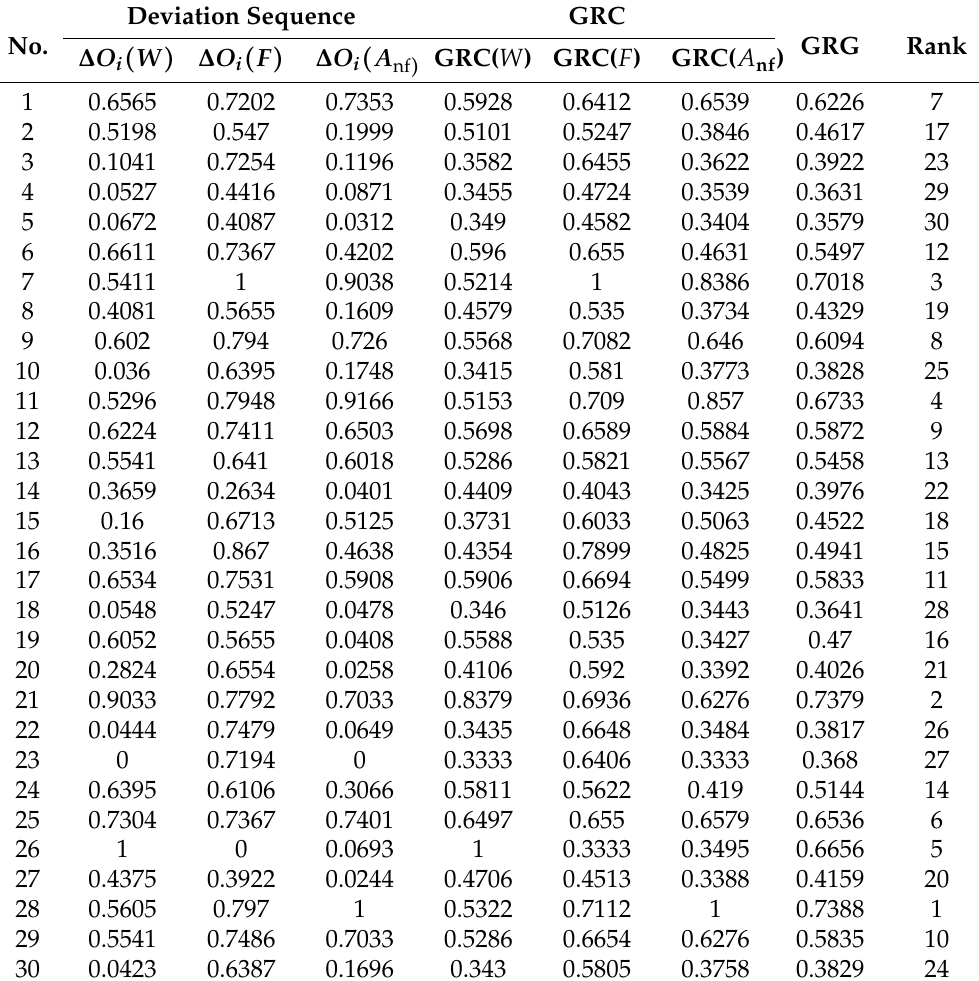
Table 11. Grey relational analysis (GRA)